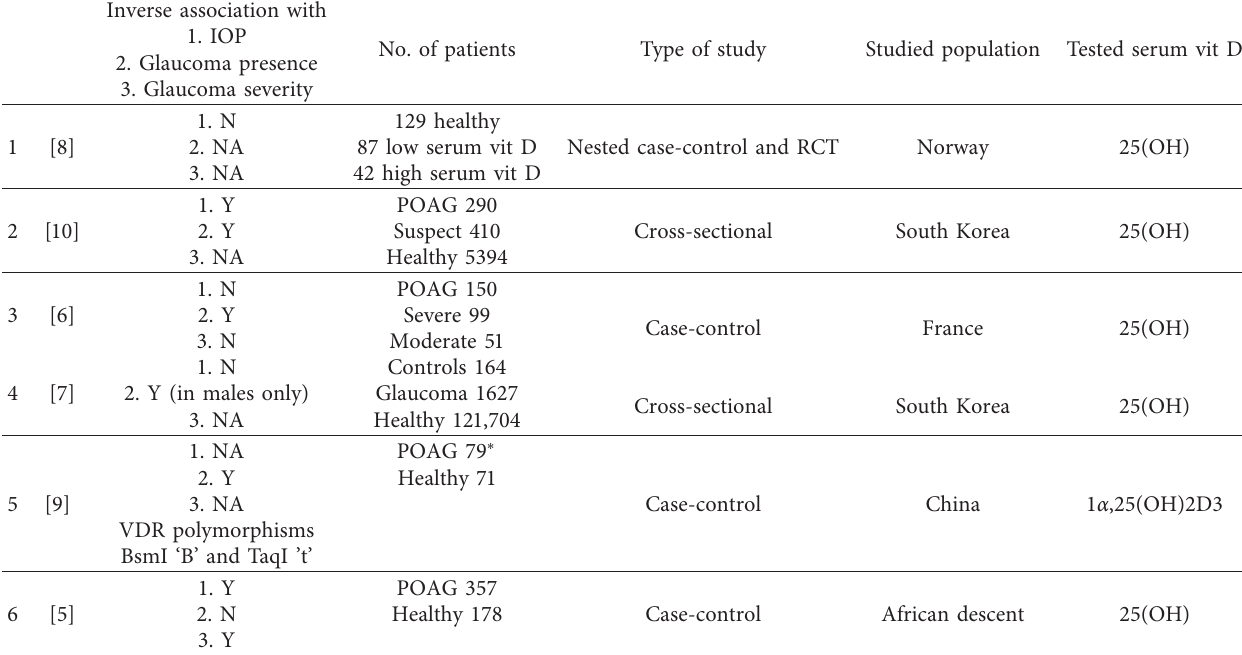
Table 2: Summary of the reviewed clinical studies and their findings. Inverse association